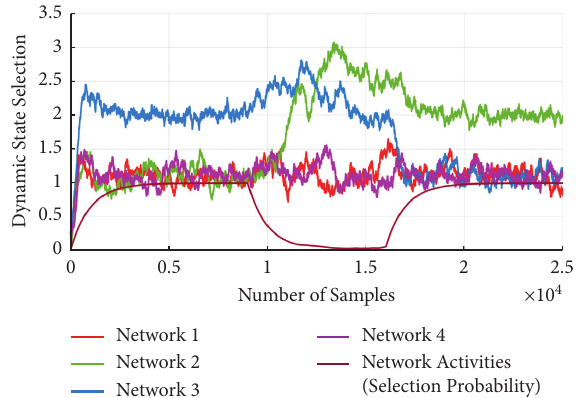
Figure 27: Effect of noise � 1W on network connectivity for threshold � 2 and sensitivity � 5.